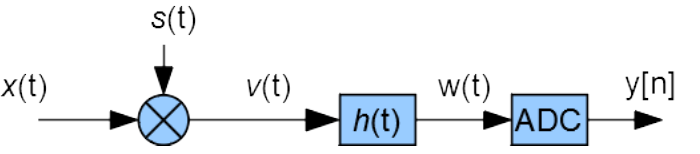
Figure 1. Principle of MWC acquisition (one physical